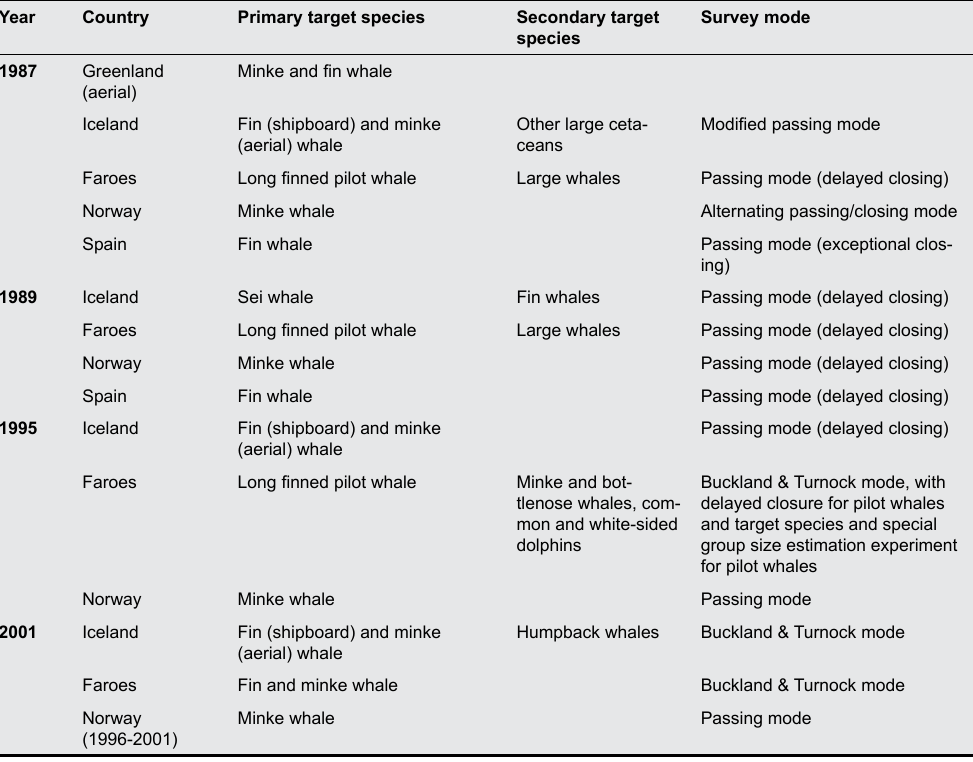
Table 1 . Target species and survey mode for all NASS cruises 1987